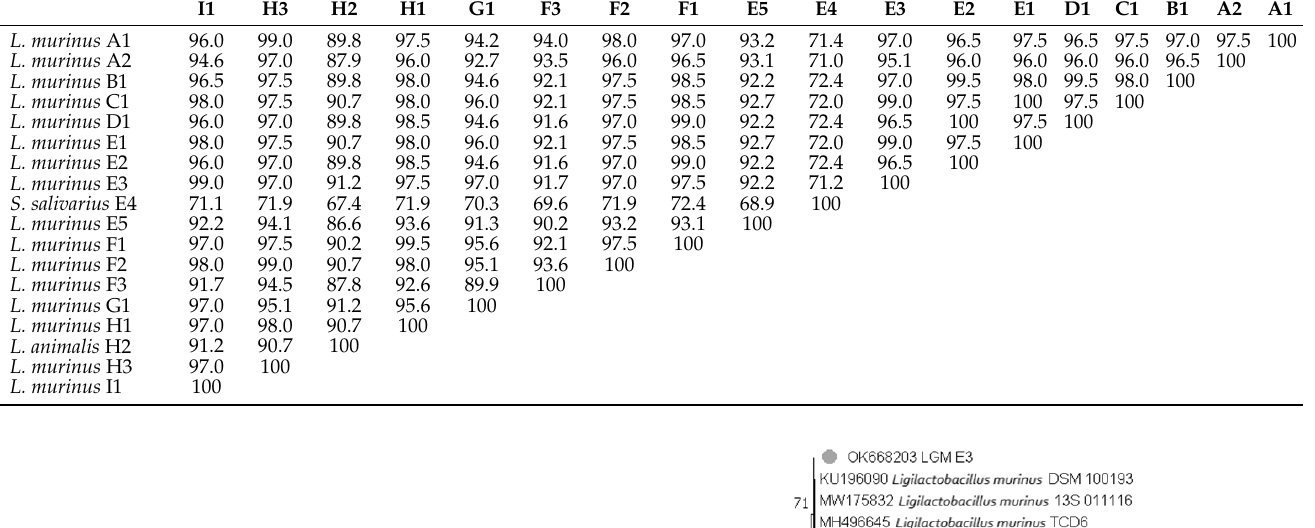
Table 2. Identity percentage matrix. Similarity values of the V2 variable region of the 16S rRNA gene of the isolated LAB.